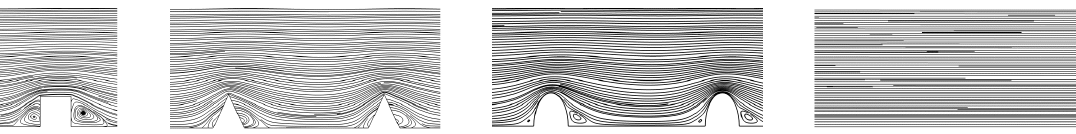
Figure 25. The streamline distributions at Re = 50.